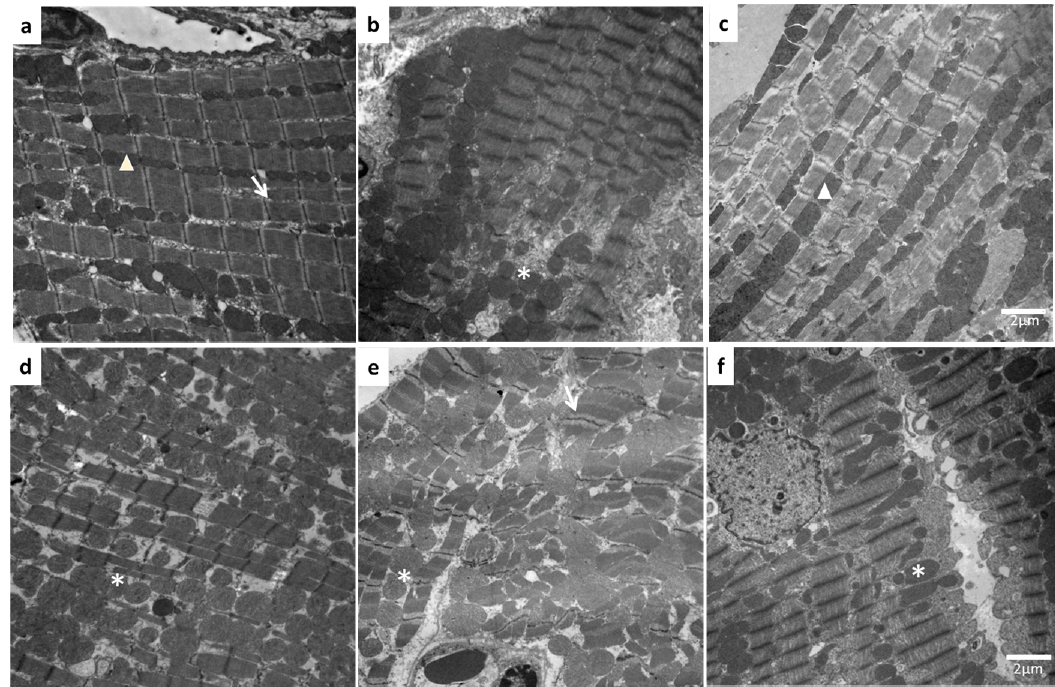
Figure 7. Fenofibrate attenuated myocardial ultrastructural damage in MetS and myocardial infarcted rats. CT-Sh ( a ); CT-MI-V ( b ); CT-MI-F ( c ); MetS-Sh ( d ); MetS-MI-V ( e ); MetS-MI-F ( f ). Details by electron microscopy in sarcomere. Mitochondria arranged in rows ( Δ ); I band ( → ); swollen mitochondria (*). Magnification 8000×, scale bar represents 2 μ m. Images are representative of six different experiments.